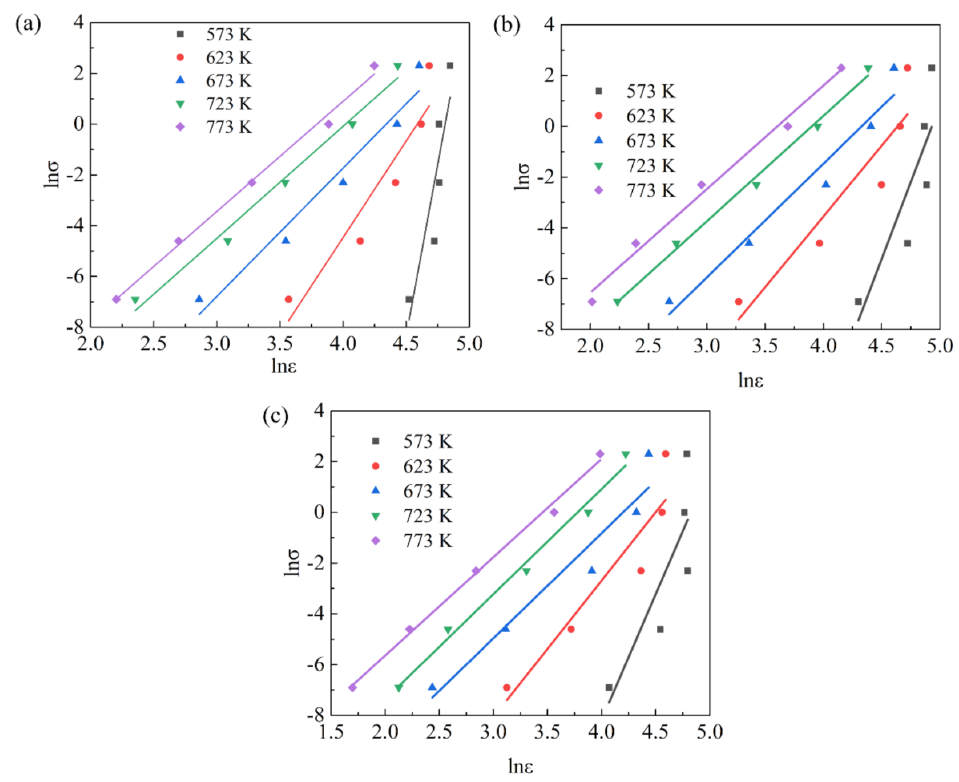
. ε Figure 9. The relationship of ln σ -ln , ( a ) ε = 0.1, ( b ) ε = 0.3, ( c ) ε = 0.5. Figure 10 shows the processing maps and instability diagram which were superposed by power dissipation diagram and the stress–strain curve of the Mg-2.5Nd-0.5Zn-0.5Zr alloy at strain variables 0.1, 0.3 and 0.5, respectively. The value of the isoline in the figure represents the percentage of the power dissipation factor ( η ), which represents the energy consumed by the change of the tissue during thermal deformation. Generally, the value of η corresponding to DRV ranged from 20 to 30%, whereas that of DRX pairs was above 30%. . ε ) In Figure 10, the gray shaded area represents the region where ξ ( was less than 0, i.e., the instability zone of plastic flow. When ε was 0.1, η increased with increased temperature and decreased with strain rate in the range of 573~723 K. At 773 K, the value of η showed a decreased trend. When ε was 0.3 and 0.5, the variation law was essentially the same as when ε was 0.1. When ε was 0.1, the η of the instability zone was less than 30%. The instability zones were two discontinuous zones at 573–592 K and 0.001–0.555 s − 1 , and 759–773 K and 2.513–10 s − 1 . The stable region was at 592–773 K and 0.001–10 s − 1 . When the ε increased to 0.3, the η of the instability region reached 35%, and the instability region was 573–773 K and 0.003–1.176 s − 1 . The stable regions were 573–610 K and 0.001–0.003 s − 1